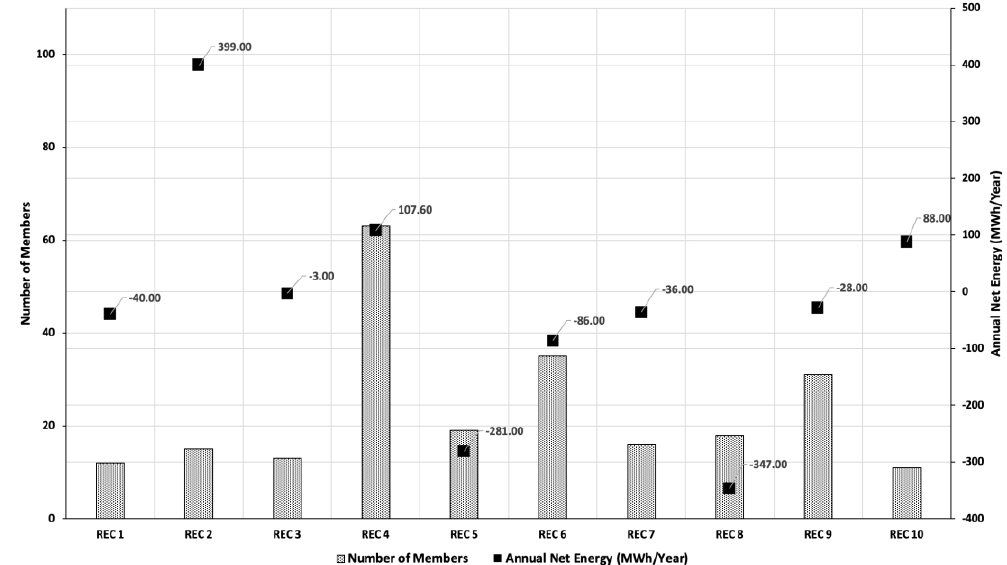
Figure 17. Number of members and annual net energy by REC —Ward’s method.